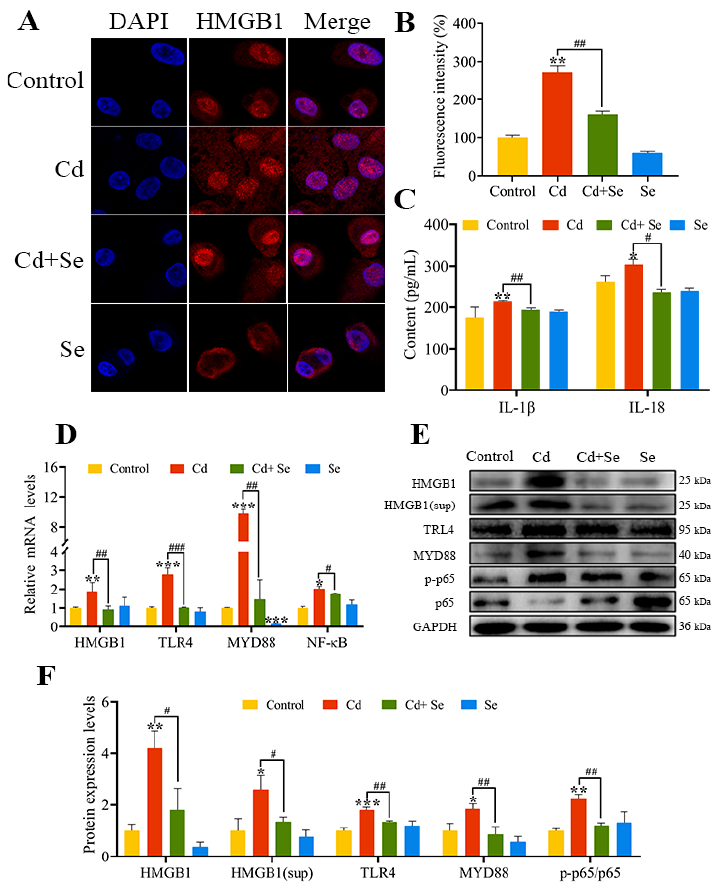
Figure 5. Se relieves the activation of high-mobility group box 1 (HMGB1)/nuclear factor- κ B (NF- κ B) signaling pathway induced by Cd. ( A , B ) HMGB1 immunofluorescence analysis. Blue: nucleus; Red: HMGB1; ( C ) The release of IL-18 and IL-1 β in the culture medium; ( D ) The mRNA levels of HMGB1, myeloid differentiation primary response protein 88 (MYD88), Toll-like receptor (TLR) 4 and NF- κ B; ( E ) Protein band graph; ( F ) The protein levels of HMGB1, MYD88, TLR4, p65 and p-p65. The data are expressed as mean ± SD. “*” indicates a significant difference compared with control group (* p < 0.05, ** p < 0.01 and *** p < 0.001). “ # ” indicates a significant difference between Cd group ( # p < 0.05 and ## p < 0.01, ### p < 0.001).